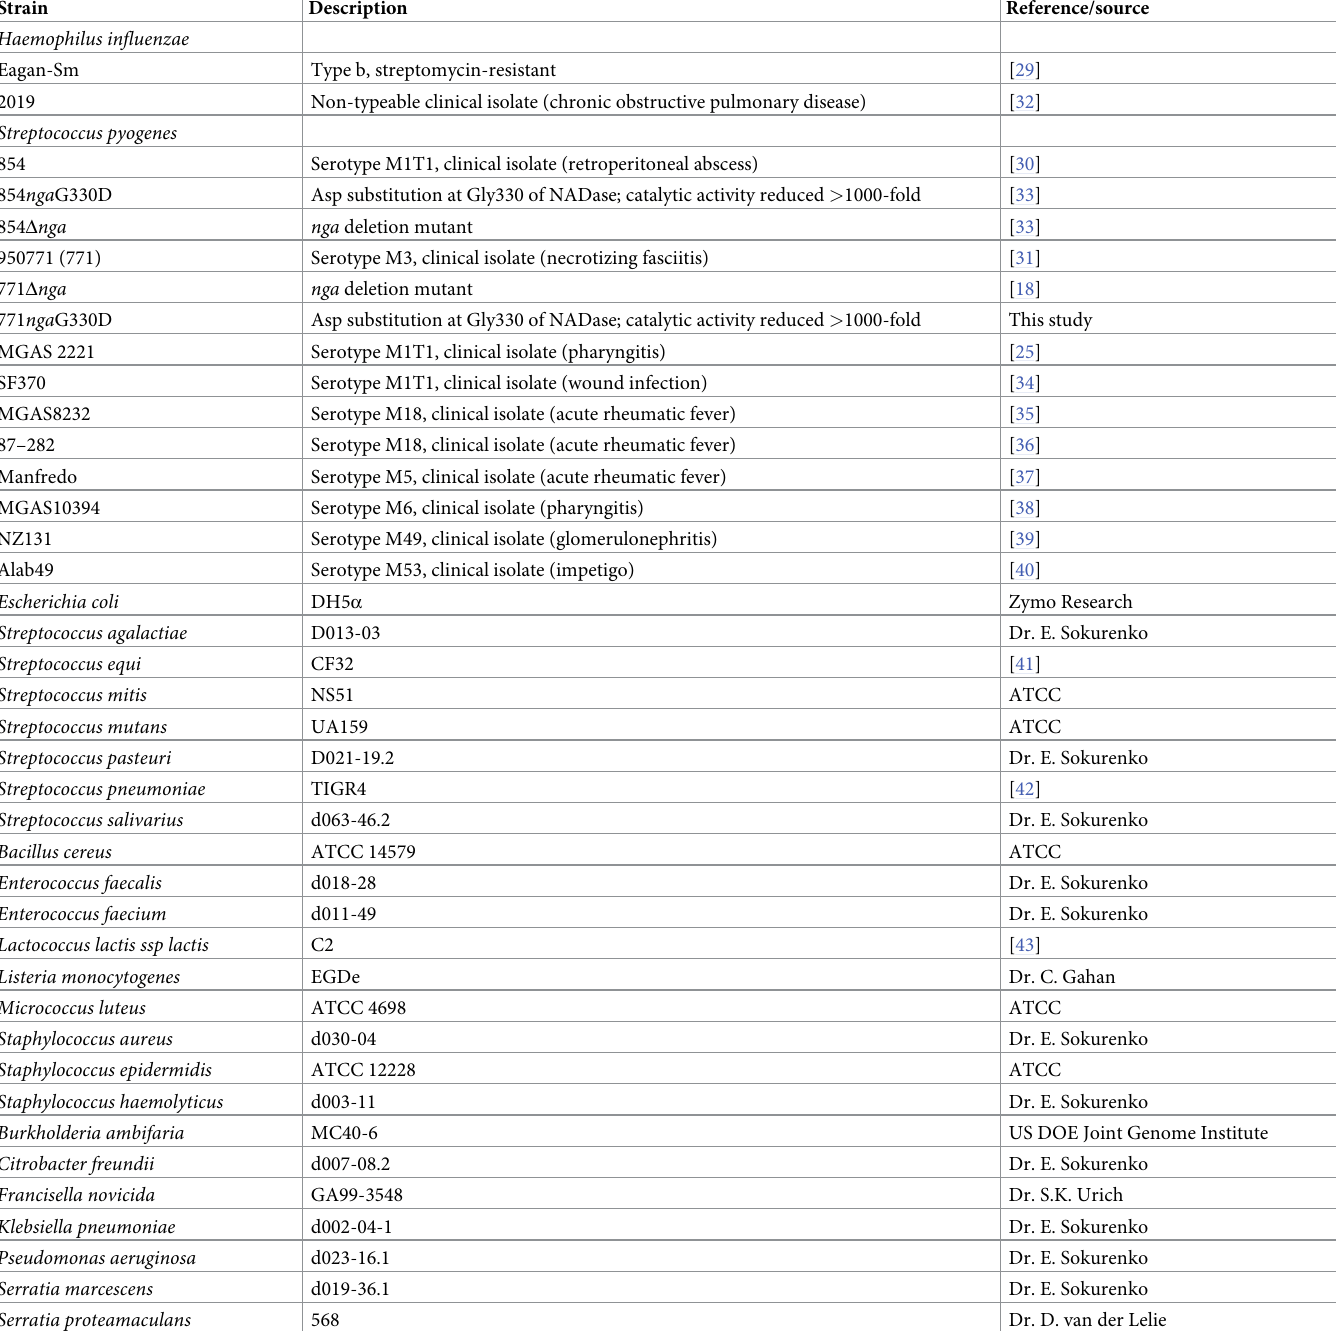
Table 2. Bacterial strains used in this